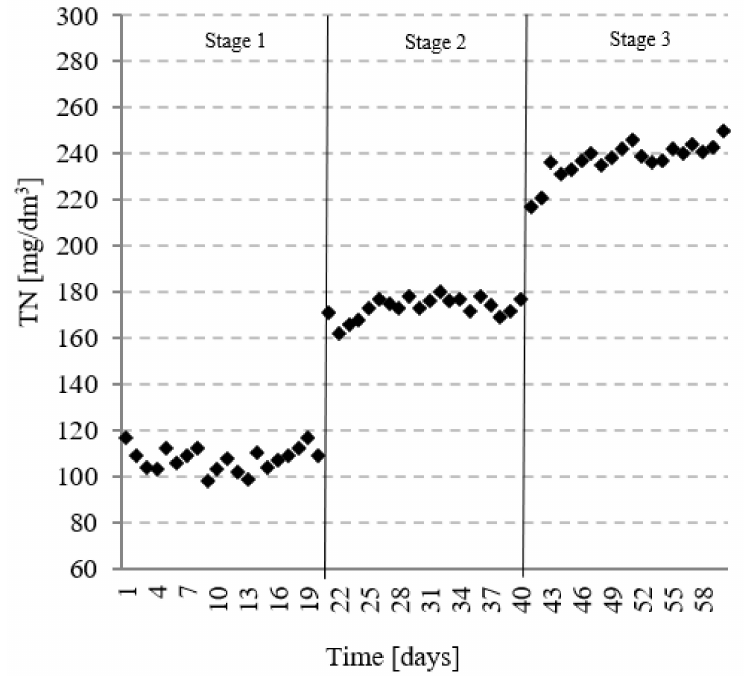
Figure 9. Changes in the total nitrogen concentration in the treated e ffl uent.